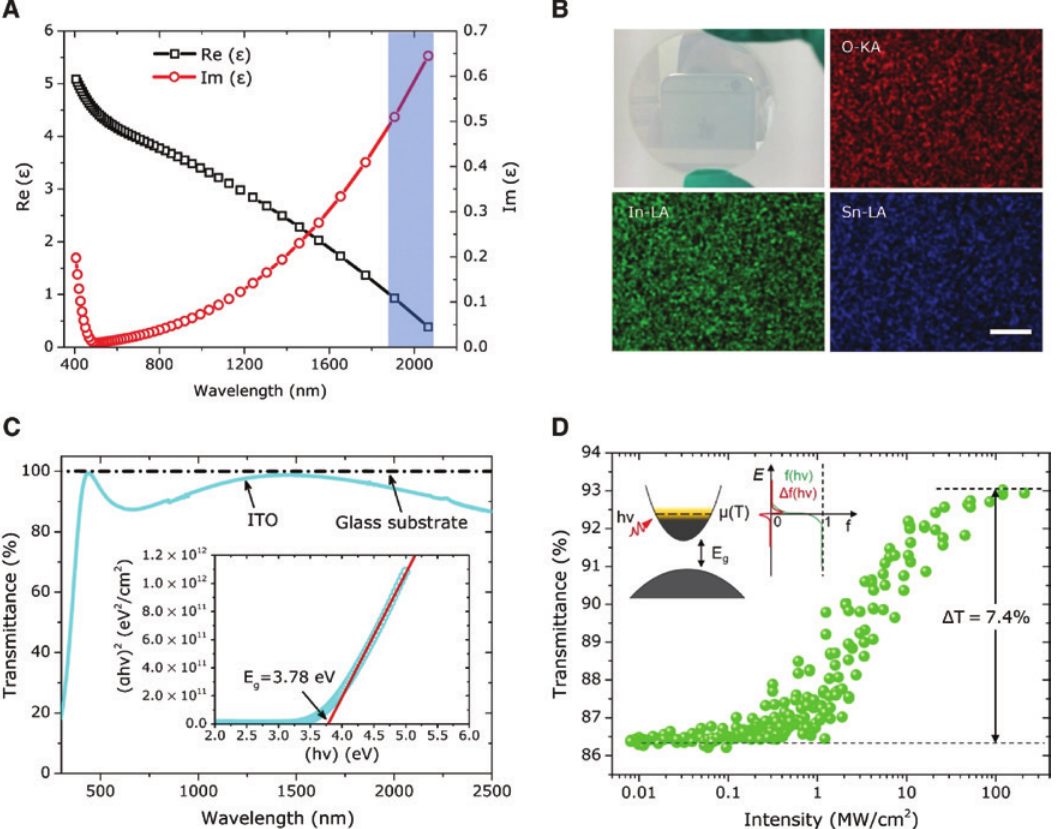
Figure 1: Characterization of the ITO film. (A) The electrical permittivity of the ITO film from 400 to 2100 nm, limited to the measurement apparatus. The ENZ wavelength of the ITO film is ~ 2000 nm. The blue shadow indicates the nonlinear transmission characterization and laser operation band. (B) Photo image of the 4-in. ITO film coated on a glass substrate and the element maps of the ITO film. KA and LA indicate the electron shells. Scale bar: 2 μ m. (C) Linear optical transmittance spectrum of the ITO film. Fresnel reflection and absorption of the glass substrate are baselined with one bare glass. Inset: Optical bandgap of the ITO film extrapolated from the Tauc plot. (D) Optical transmittance of the ITO film as a function of the incident laser intensity at wavelength 1880 nm. Inset: schematic diagram showing the photon-induced electron redistribution near the Fermi